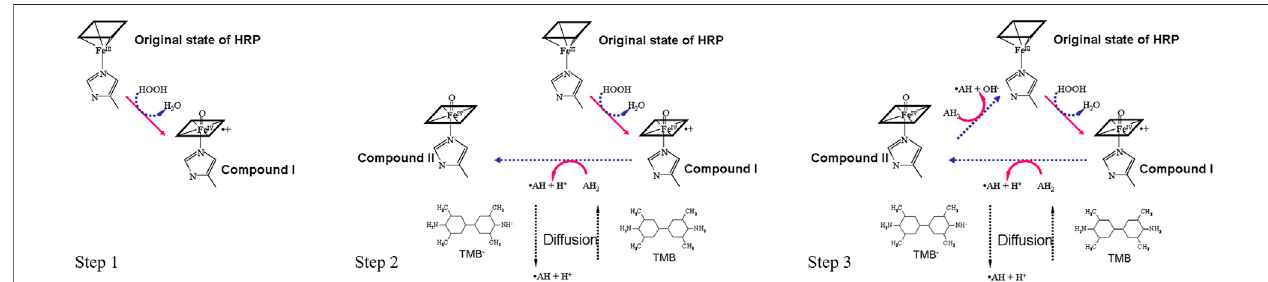
FIGURE 3 | Schematic representation of the HRP-TMB cycling enzymatic ampli fi